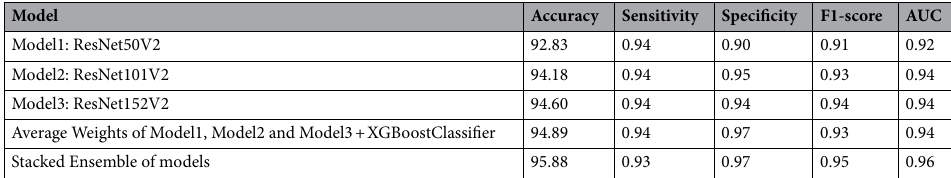
Table 8. Pathology classification results on the Private dataset.